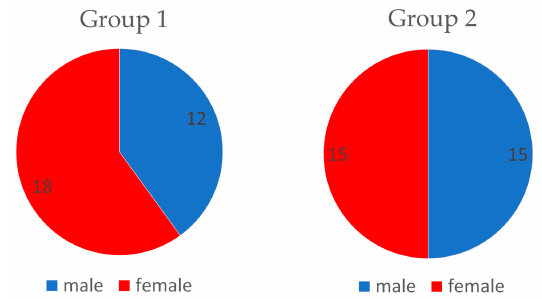
Figure 3. Distribution of gender in experimental and control groups. Table 1. Structure of Group I and Group II main descriptive values.